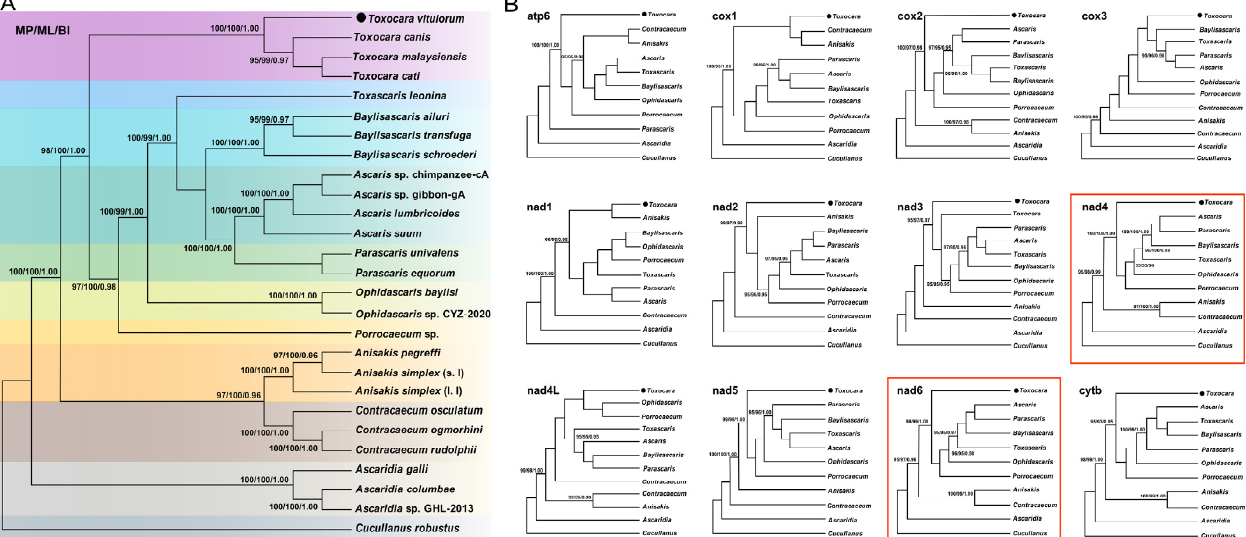
Figure 8. Phylogenetic relationships among Ascaridoidea nematodes. The phylogeny is inferred using the MP, ML, and BI methods of 27 Ascaridida species for which complete mitogenome sequences are available, using the Seuratoidea species ( C. robustus ) as the outgroup. ( A ) Phylogenetic tree is based on concatenated amino acid sequences of 12 PCGs. ( B ) Twelve topological phenograms are based on each PCG, and the tree topology consistent with the trees in A are marked with red line boxes. The black circle sign represents the species sequenced in this study. The numbers along the branches in A and B indicate bootstrap values/posterior probabilities (<95% or 0.95 supports not shown) resulting from different analyses in the order MP/ML/BI.